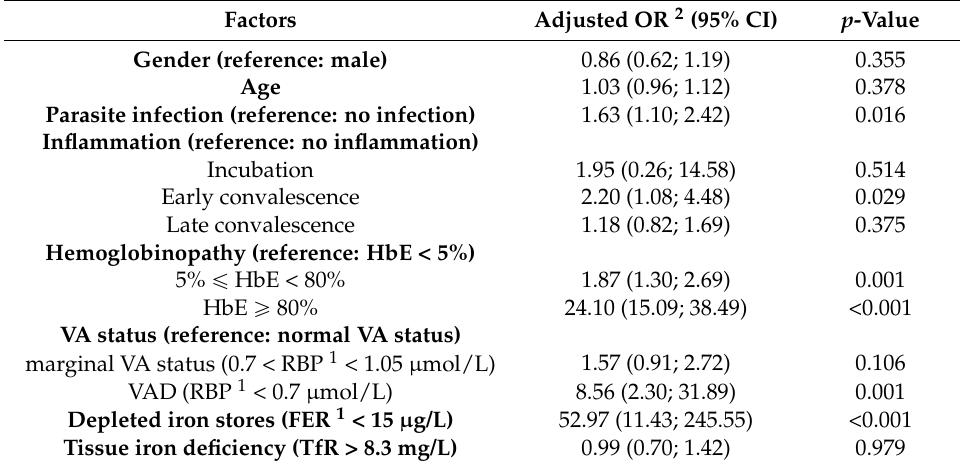
Table 3. Risk factors for anemia at